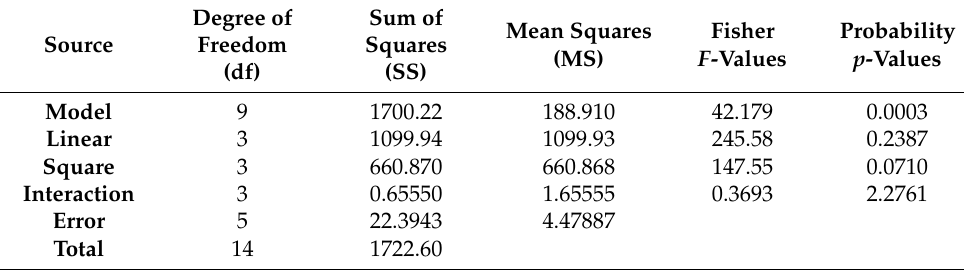
Table 3. ANOVA statistics test for the BBD model